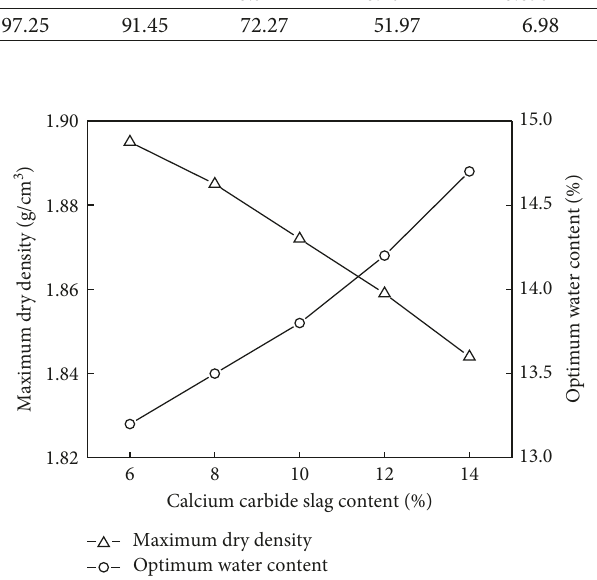
Figure 4: Compaction curves of the mixtures with different cal- cium carbide slag contents.